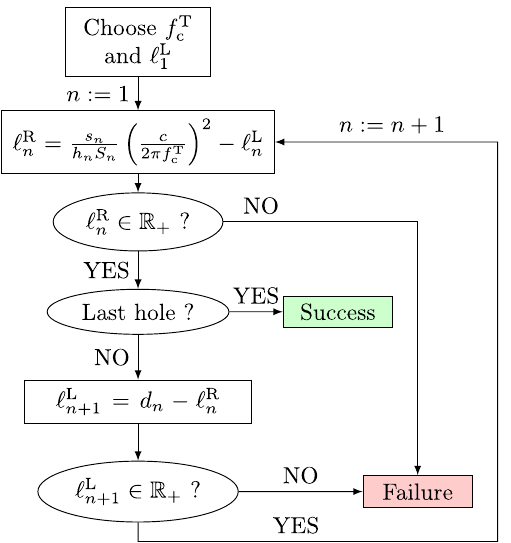
Figure 8. A fl owchart of the asymmetric division algorithm described in Section 3.2 used to divide the acoustically regular lattices shown in Figure 9 and alto saxophone in Figure